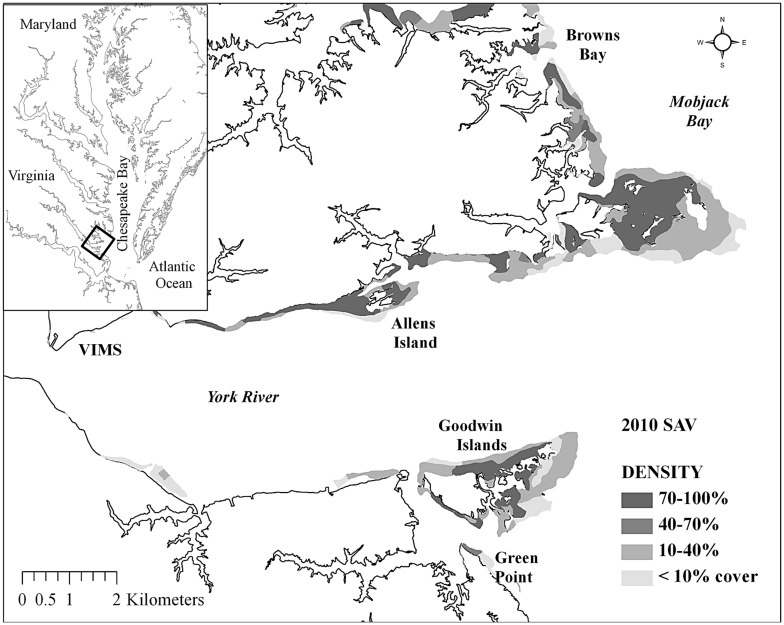
Diamondback terrapin collection locations from southwestern Chesapeake Bay SAV beds.Collection locations for diamondback terrapins from SAV beds of (A) Allens Island, (B) Goodwin Islands, and (C) Green Point along the lower York River subestuary and from (D) Browns Bay in southeastern Mobjack Bay, southwestern Chesapeake Bay (rectangle on inset). Modified from Orth et al. 2011.